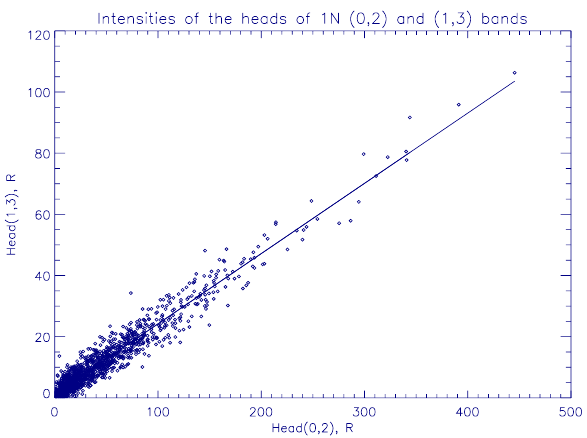
Fig. 8. Plot of Head(1,3) vs. Head(0,2) in electron aurora.